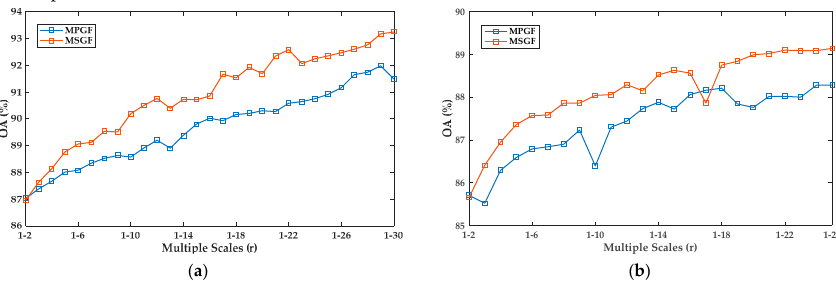
Figure 9. Performance comparison for multiple scales’ classification between the proposed MSGF and the reference MPGF techniques obtained on: ( a ) Zh1 and ( b ) Zh2.